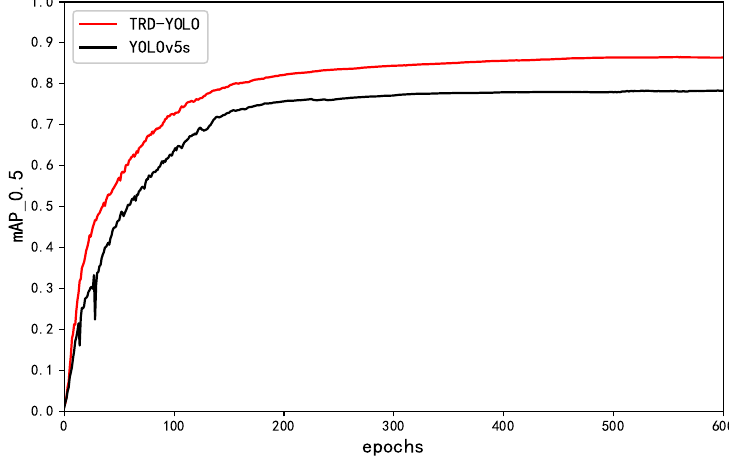
Figure 6. Comparison chart of mAP of YOLOv5s and our method.